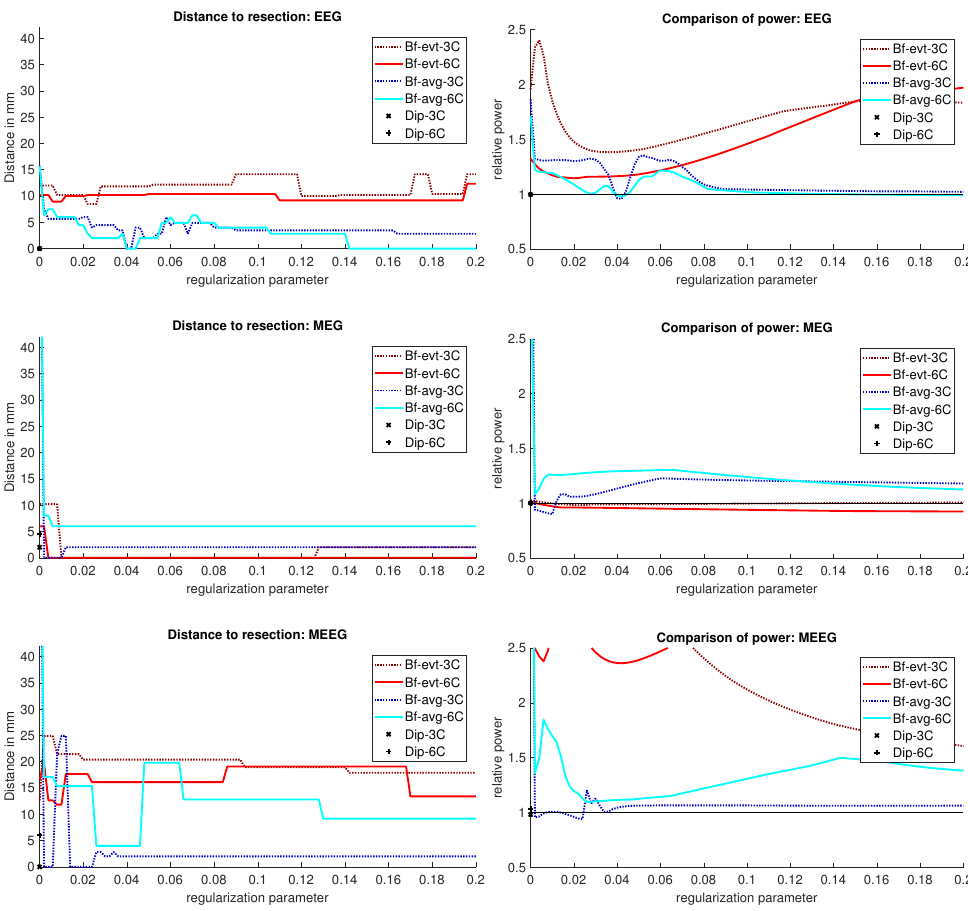
Figure 3. Localization results for patient 1. The distance of the localization of the beamformer maximum to the resection volume for each regularization value from 0 to 0.2 in steps of 0.002 is shown on the left. The corresponding power relation, which is the maximum power outside the resection volume divided by the maximum inside, is depicted on the right. Each pair of graphs is specific to one modality: EEG, MEG, and MEEG, from top to bottom. The methods are color coded in the same way for all modalities: lighter colors and full lines are used for the 6 compartment, darker dotted lines for the 3 compartment head